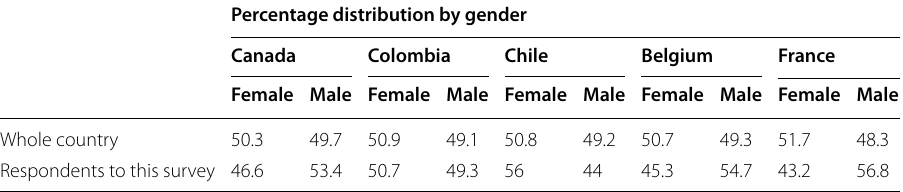
Table 1 Percentage distribution of respondents by gender